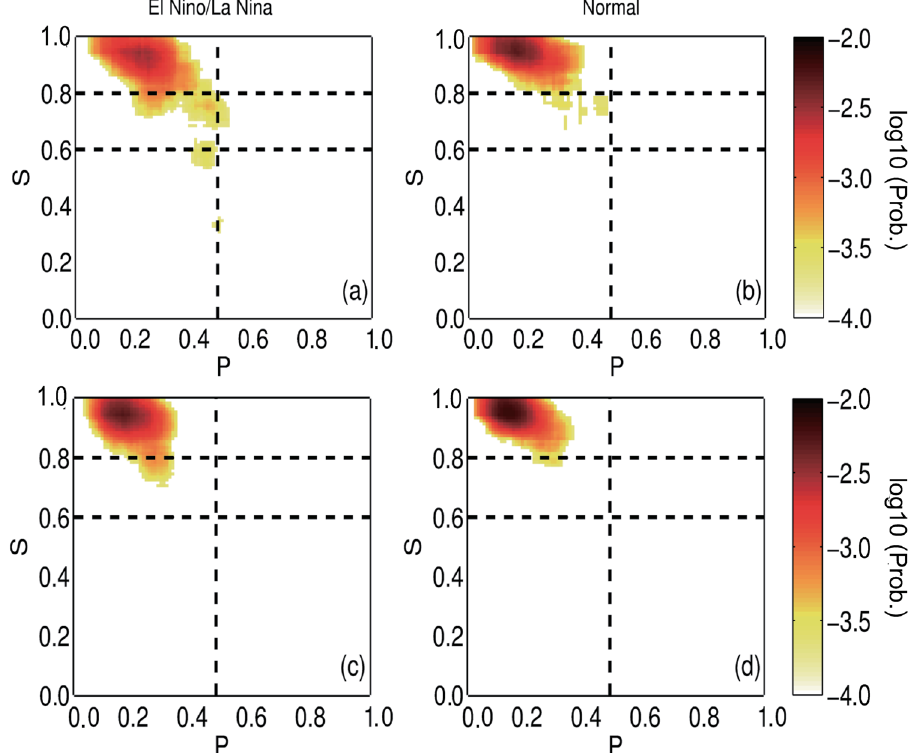
Figure 5. Simulated connections of S and P in two groups. Similar to Fig. 3, but showing the simulated results from FGOALS_s2 (upper panel) and FGOALS_g2 (lower panel). FGOALS_s2 exhibits better performance and reproduces the percolation phase transition successfully at P = 0.48 (the vertical dashed